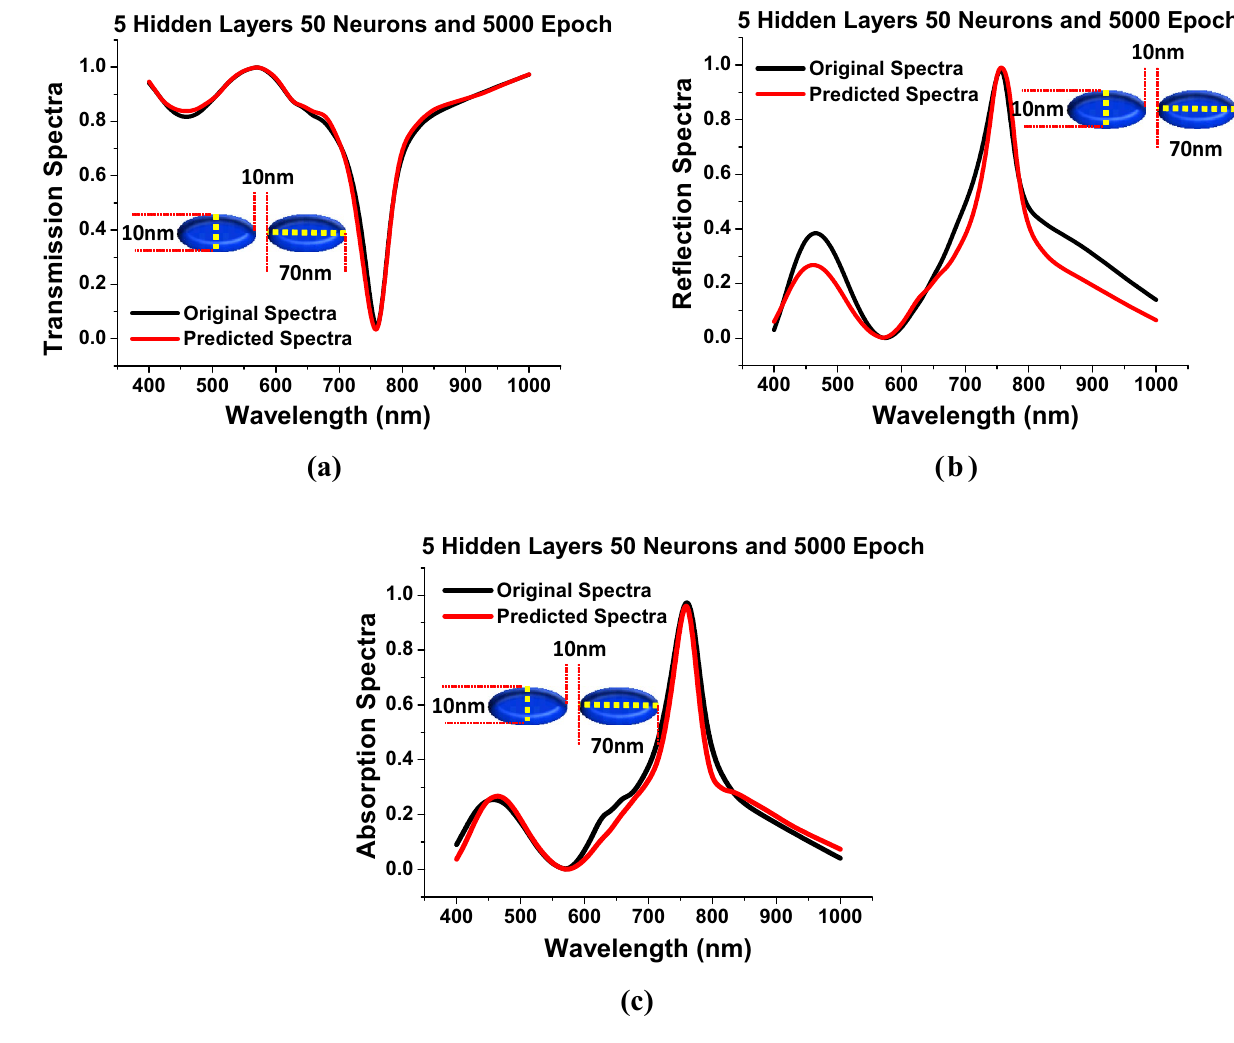
Figure 5. Hidden layer = 5, Neurons = 50 and Epoch = 5000 ( a ) Shows the comparison between the predicted transmission spectra with respect to the original transmission spectra. ( b ) Shows the anticipated reflection spectra are compared to the original reflection spectra. ( c ) Shows the predicted absorption spectra against the original absorption